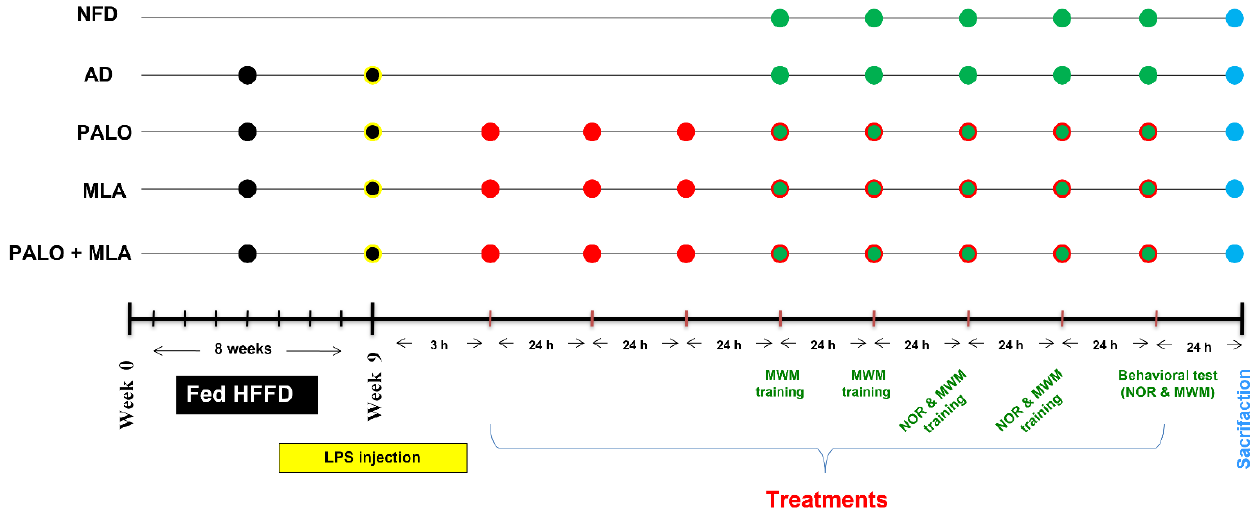
Figure 11. Experimental design time line. For 8 weeks, rats were fed NFD or HFFD to be injected on the last day with a single dose of saline or LPS (2 mg · kg − 1 , i.p), respectively. The HFFD/LPS rats were left untreated (AD model) or injected with PALO (0.1 mg · kg − 1 ; i.p) and/or MLA (5.6 mg · kg − 1 ; i.p) for 8 days starting 3 h after LPS injection. In the combined group, MLA was injected 15 min before PALO. On day 4 after LPS, MWM training was performed and the probe test was done on day 8. The NOR test, habituation and familiarization phases (days 6 and 7) were followed by the probe test (day 8). Rats were euthanized 24 h after the last dose of treatment.